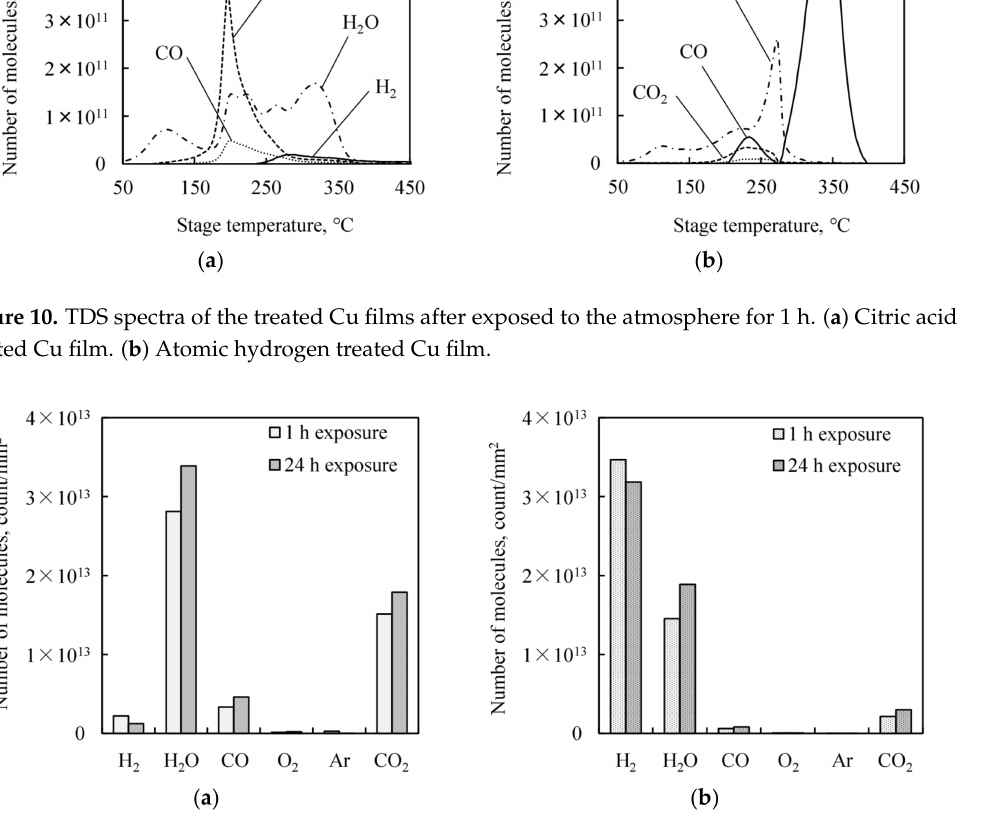
Figure 11. Total amounts of desorbed molecules in the TDS measurements. The treated Cu films are exposed to the atmosphere for 1 or 24 h. ( a ) Citric acid treated Cu film. ( b ) Atomic hydrogen treated Cu